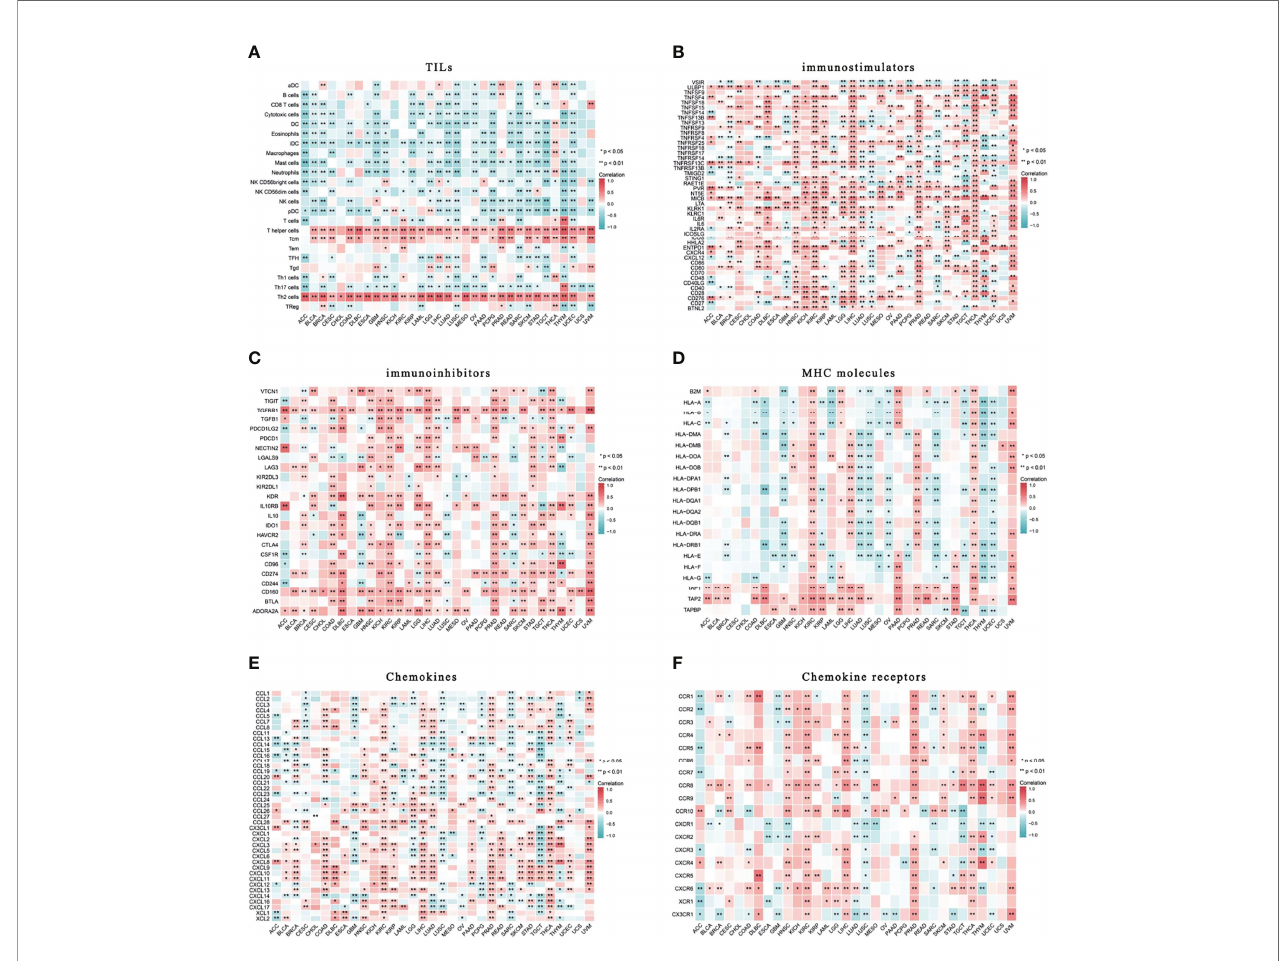
FIGURE 12 | Correlation of HELLS with TILs and immunoregulation-related genes in 33 cancers. Correlations between HELLS expression and (A) TILs, (B) Immunostimulators, (C) Immunoinhibitors, (D) MHC molecules, (E) Chemokines, (F) Chemokine receptors. ∗ p < 0:05, ∗∗ p <